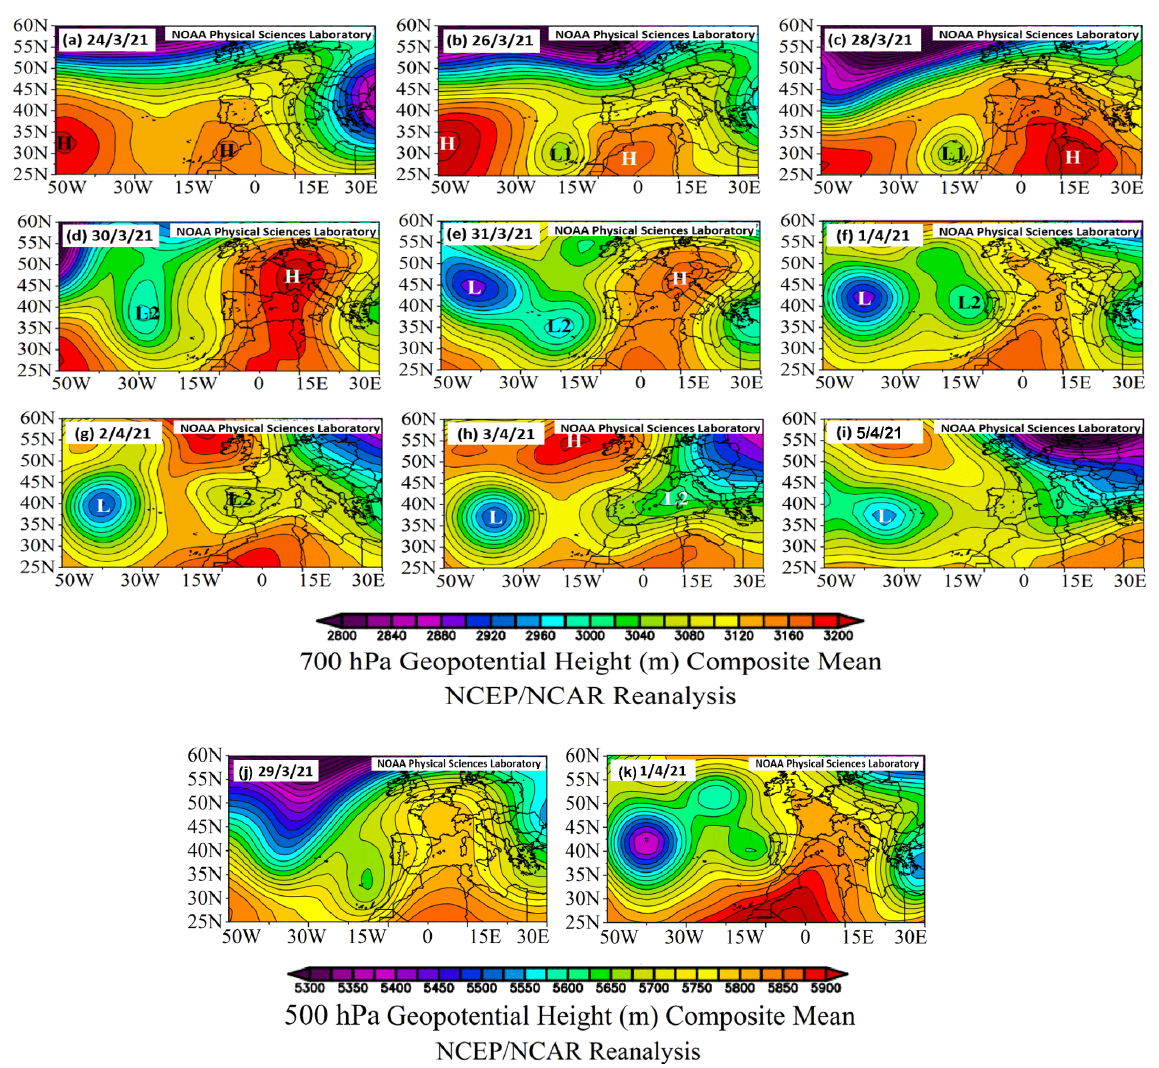
Figure 2. (a–i) The 700hPa geopotential height (in m) composite mean for several significant days of the dust outbreak: 24, 26, 28, 30, and 31 March (a–e) and 1, 2, 3, and 5 April 2021 (f–i) . High- and low-pressure systems are indicated by H and L, respectively. (j, k) Geopotential height (in m) composite mean for 29 March and 1 April 2021 at 500hPa. Images provided by the NOAA/ESRL Physical Sciences Laboratory, Boulder Colorado (http://psl.noaa.gov/, last access: 11 April